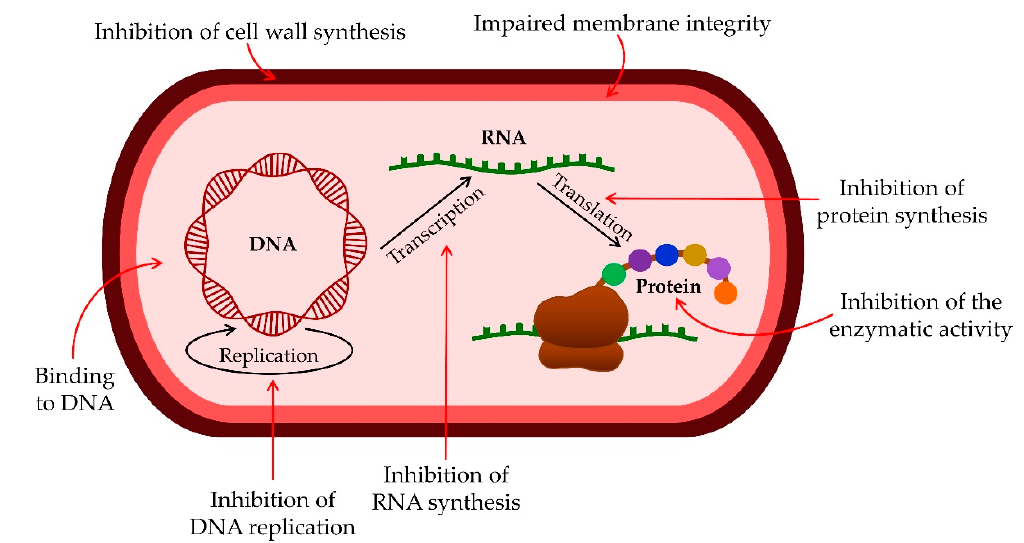
Figure 5. Antibacterial activity mechanisms of AMPs.